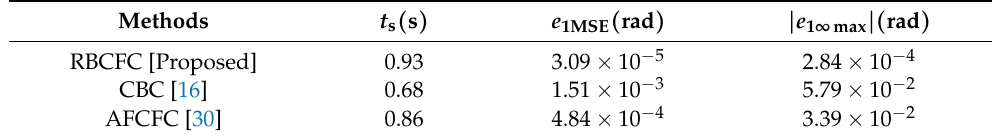
Table 1. Performance indexes under the three